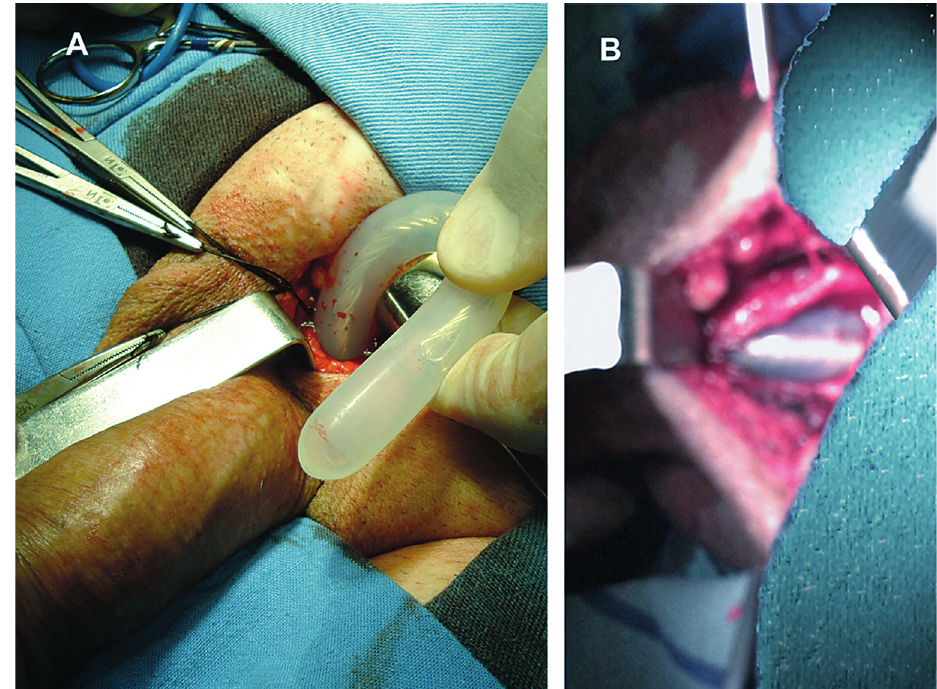
Figure 5 – Prosthesis